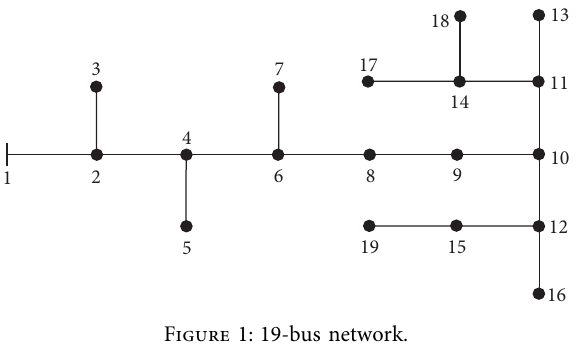
Figure 1: 19-bus network.